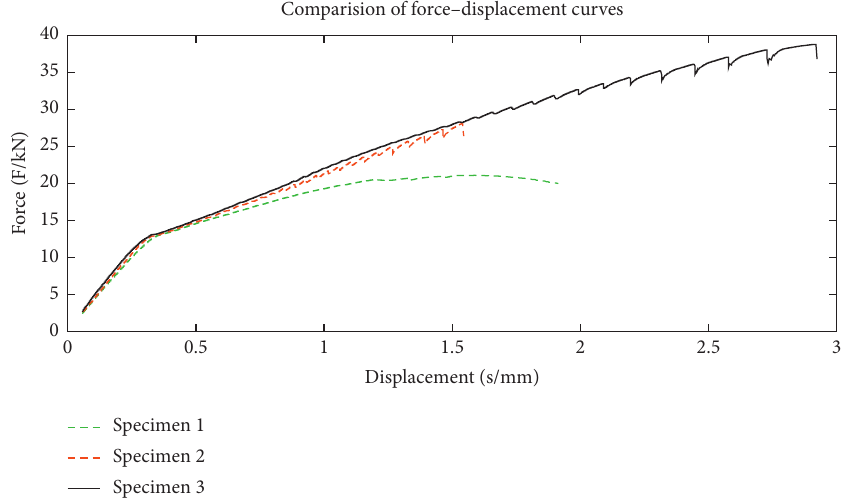
Figure 15: Comparison of force-displacement curves of three kinds of